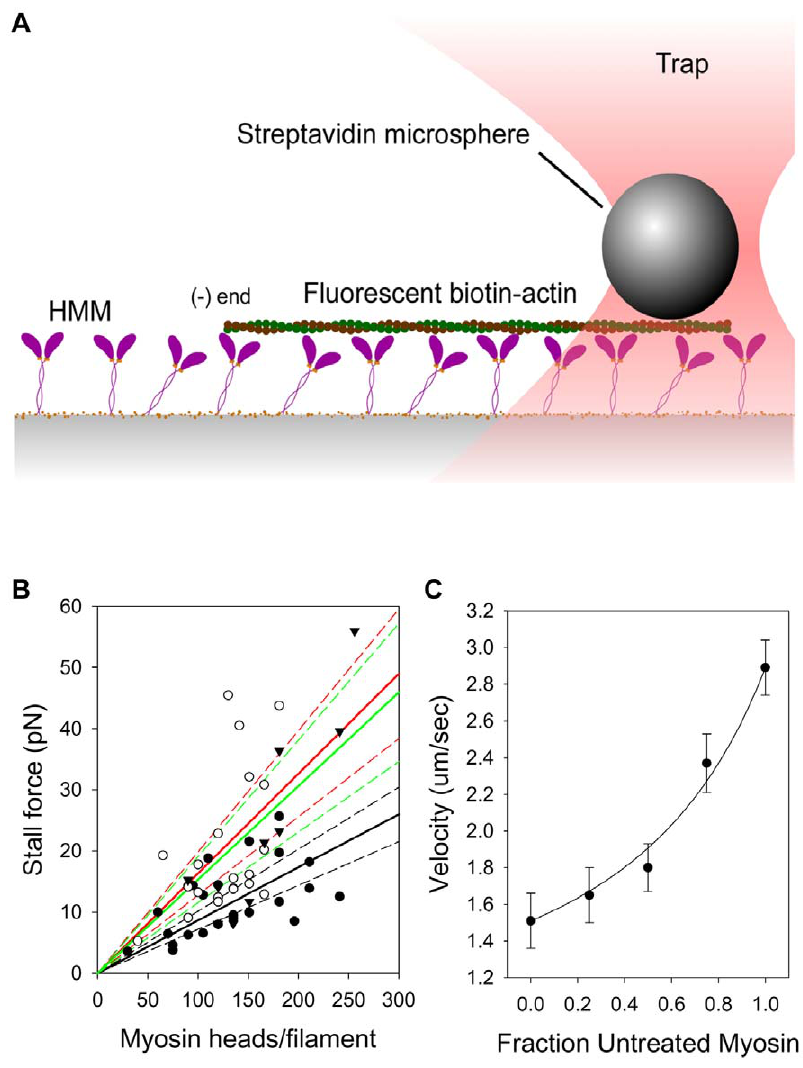
Figure 2. Measurement of time-averaged isometric force after exposure to NO. A: A streptavidin-coated bead is held in a laser trap and touched to the trailing ( + ) end of a moving, biotinylated, TRITC-phalloidin labeled actin filament. Displacement of the bead from trap center was N followed using back focal plane interferometry [34,35]. B: Force versus number of potentially bound, force-generating heads (a reflection of filament , black lines), 10 m M DEA NONOate ( # , red lines) and 100 m M DEA NONOate ( . , green lines). Steeper slopes length) for three conditions, control ( indicate proportionately higher forces per head. Solid lines indicate the regression fit, while the dashed lines show 95% confidence intervals. Each data point is an independent force measurement (N=25, 20 and 10 for 0, 10, and 100 m M DEA NONOate respectively). C: Mixtures experiment for rat cardiac myosin. The line shows the fit of equation 1 from Harris et al. [11] yielding a relative force production 2.1-fold higher after DEA NONOate- treated compared to control. N=3.